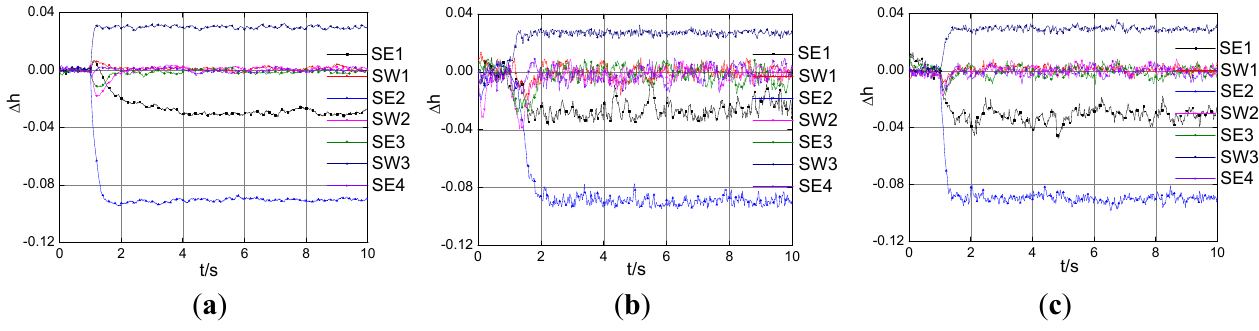
Figure 4. Health parameters estimation with Gaussian noise under the Fault 2. ( a ) the EKF; ( b ) the PF; ( c ) the